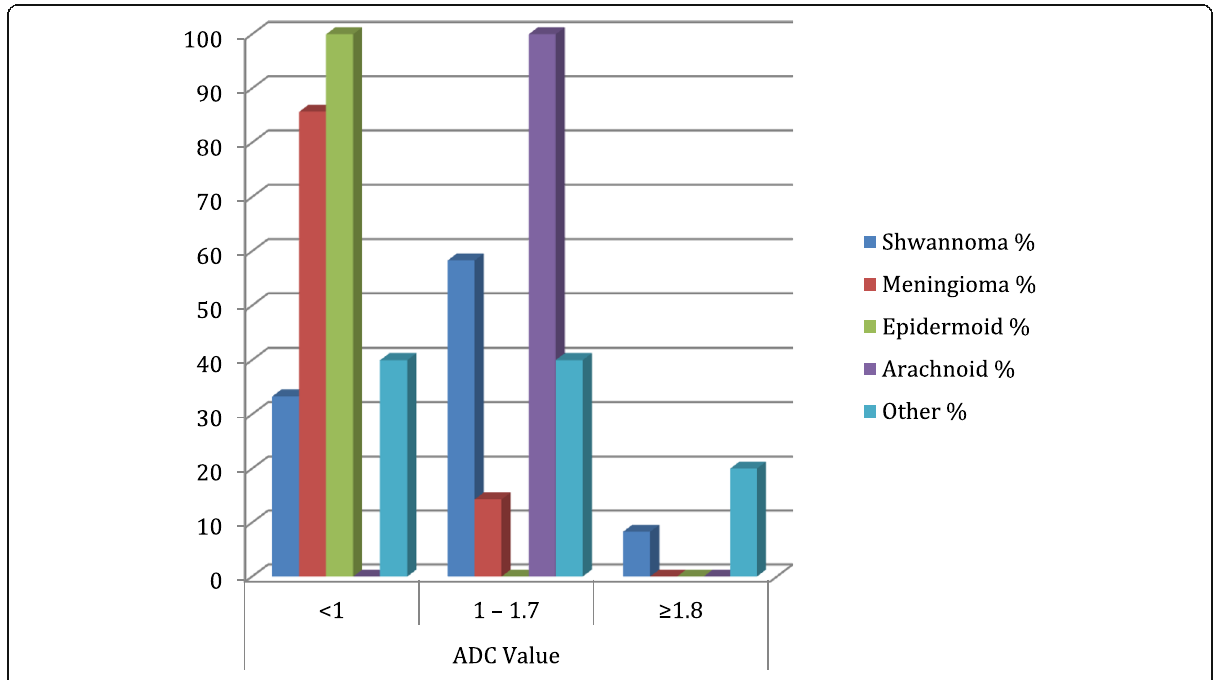
Fig. 1 Chart showing the distribution of ADC values among different CPA pathologies